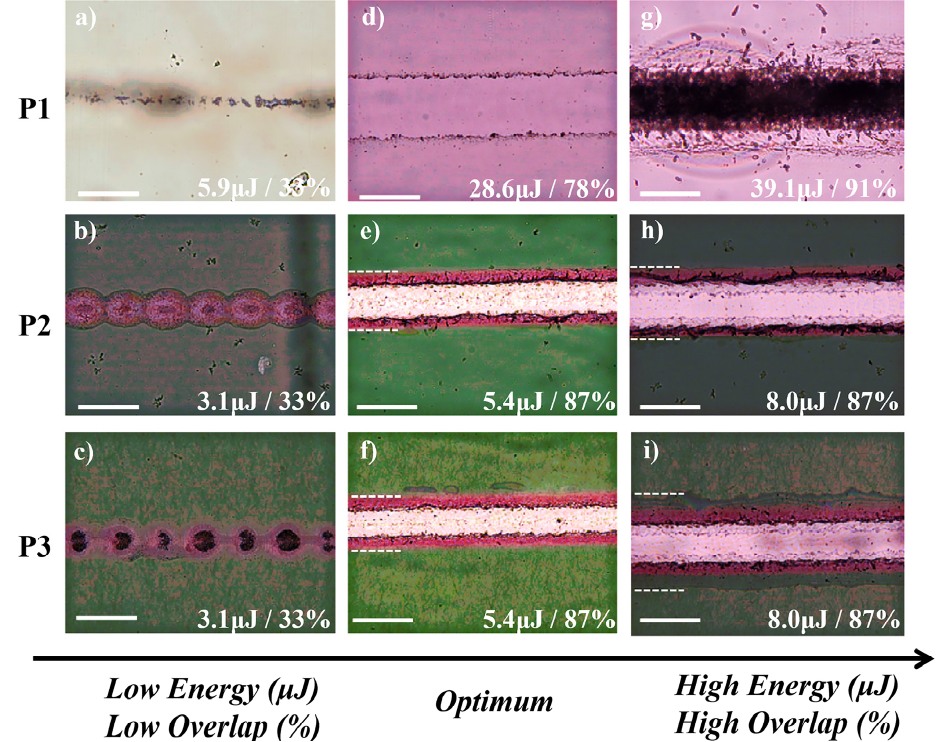
Figure 3. Optical microscopy images for below ( a – c ), optimum ( d – f ) and above ( g – i ) ablation threshold of P1, P2 and P3 processes. The white line indicates a 40 µ m scale and dash line represent heat-affected zone outer